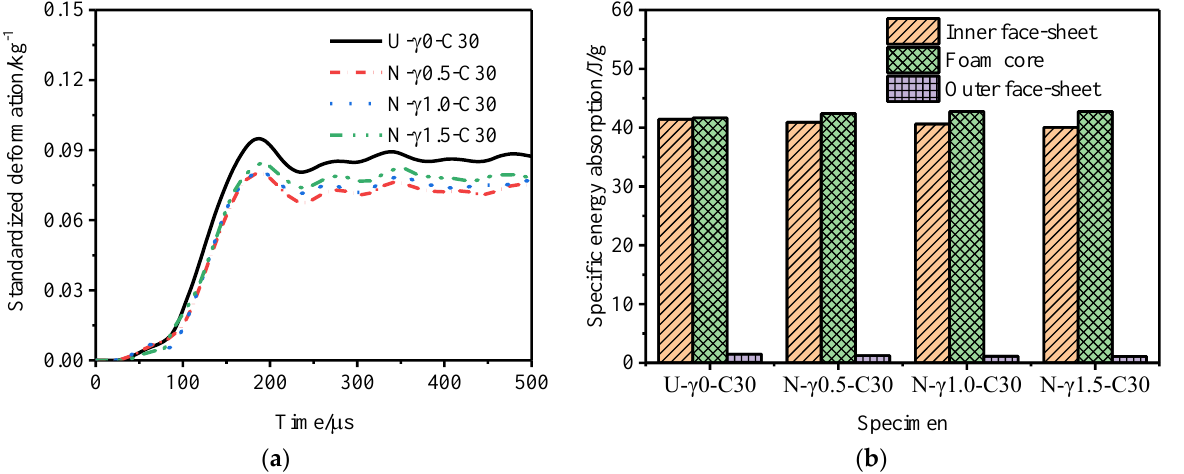
Figure 15. Anti − explosion performance of an N-type aluminum foam sandwich tube. ( a ) Deformation curve of the outer tube and ( b ) specific energy absorption of sandwich tube.